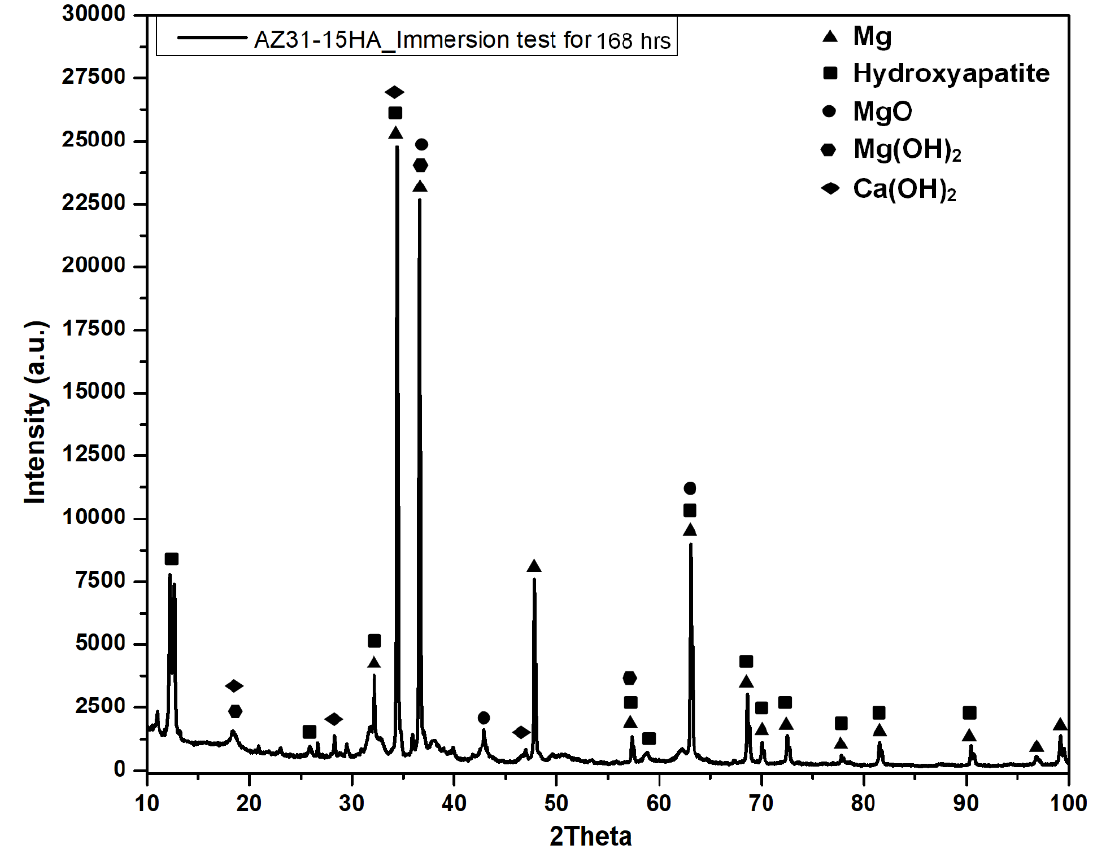
Figure 11. XRD spectra of AZ31-15HA BMMC after immersion test for 168 h.